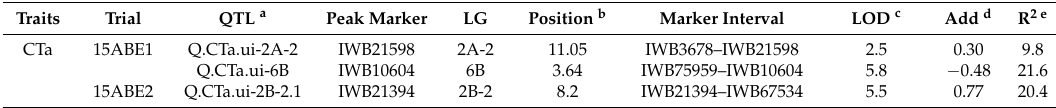
Table 4. Quantitative trait locus (QTL) detected for canopy temperature in the DH population of UI Platinum/SY